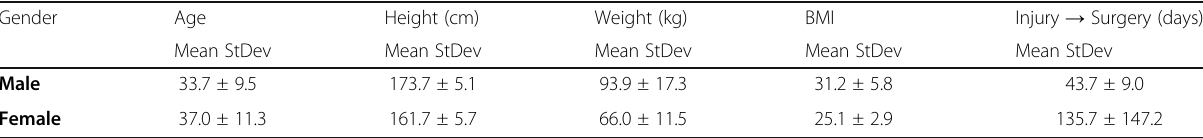
Table 1 Patient